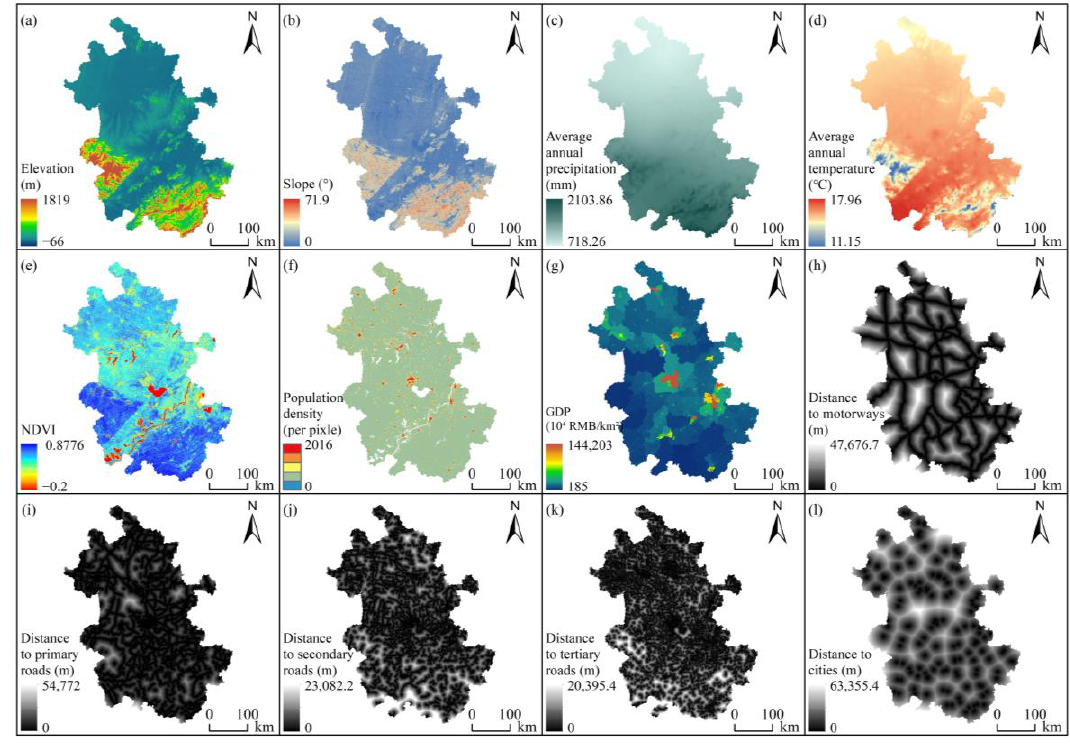
Figure 3. Driving factors for changes in land use. Table 2. Neighbourhood weights.